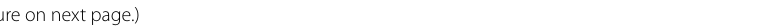
**90%–100%(See figure on next Fig. 3 Neutralization activity analysis of purified antibodies on infection of SARS-CoV-2 pseudovirus to ACE2 + HEK293. a Four linear B cell epitopes, including LFRKSNLKPFERDISTE (455–47, E1), YQAGSTPCNGV (473–483, E2), GFQPTNGVGY (496–505, E3), and QQFGRDIADTTDAVRDPQ (563–580, E4). E1, E2, E3 are located on the receptor-binding domain (RBD), E4 is located on adjacent RBD. b The epitope peptides were synthesized and coupled to CNBr-activated Sepharose 4FF to purify epitope peptide-specific IgG. c The sera from 3 healthy subjects (HS) and 15 COVID-19 convalescents were diluted 160x and detected their ability to block pseudovirus by flow cytometry. GFP fluorescence intensity was compared. d The blocking efficiency of epitope peptide-specific IgG. Blue cells represent for no blocking effect (Blocking percentage < 50%?) while orange cells represent for have blocking effect. Blocking percentage(%):*45%–90%,